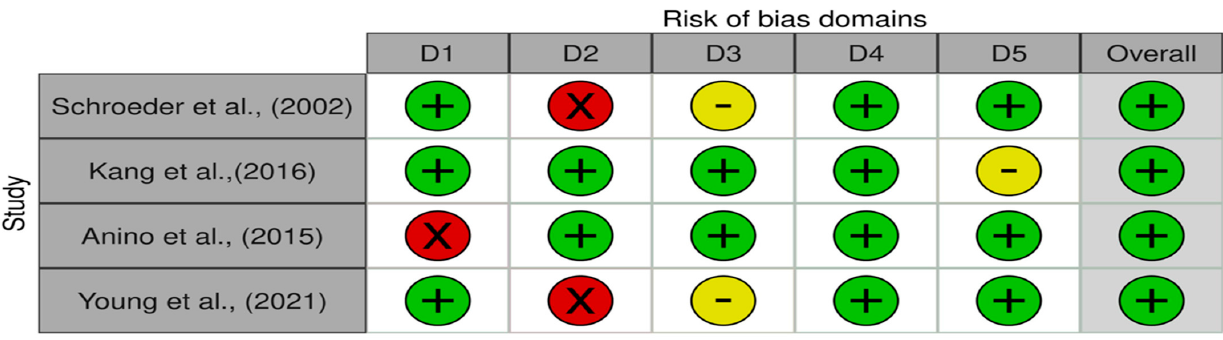
Figure 2. Assessment of the quality of articles included in the meta-analysis [28–31]. Domains: D1 = bias arising from the randomization process; D2 = bias due to deviations from the intended intervention; D3 = bias due to missing outcome data; D4 = bias in the measurement of the outcome; D5 = bias in the selection of the reported result.